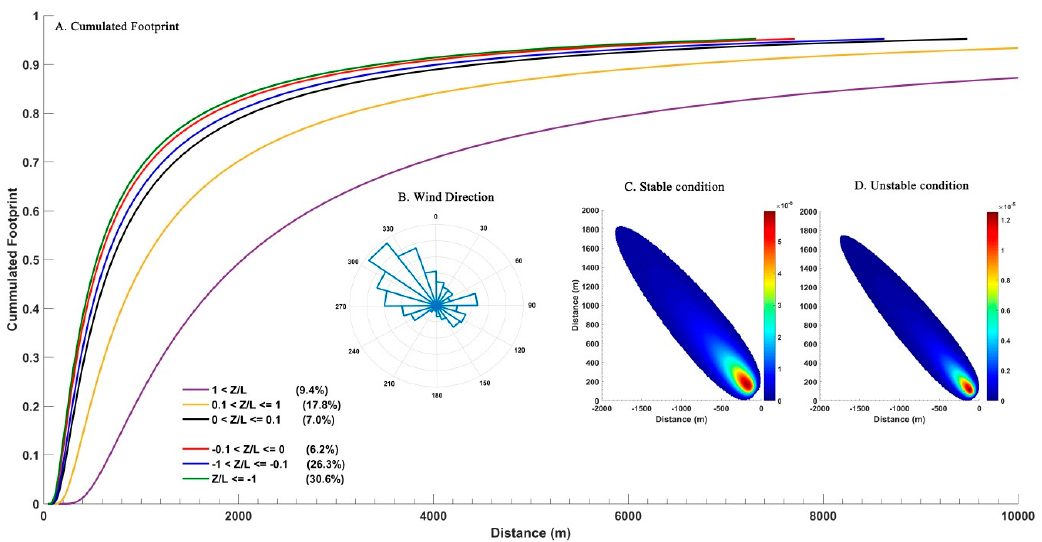
Figure 2. Footprint analysis for the eddy covariance measurement. ( A ) Cumulative footprint from the wind direction; ( B ) distribution of the wind direction; ( C ) source area under stable conditions, where the median values of wind speed were used in the calculation; ( D ) the source area under unstable conditions, where the median values of wind speed were used in the calculation.